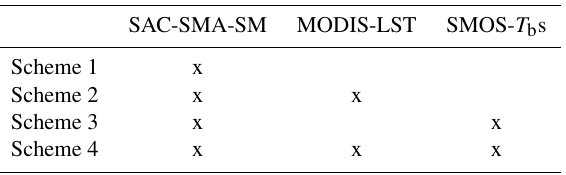
Table 3. Four data-input schemes: scheme 1: SAC-SMA-SM; scheme 2: SAC-SMA-SM and MODIS-LST; scheme 3: SAC-SMA- SM and SMOS- T b s; scheme 4: SAC-SMA-SM, MODIS-LST, and SMOS- T b